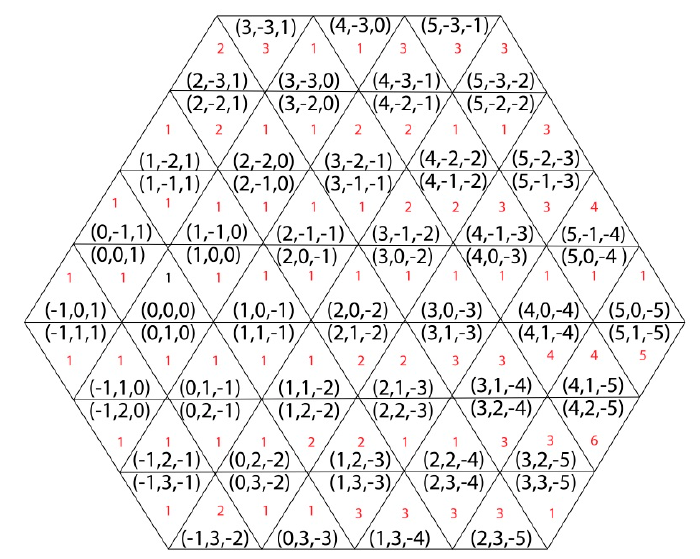
Figure 5. The number of shortest weighed paths from trixel (0,0,0) to some other trixels with the condition 2 α < β < γ < 3 α .